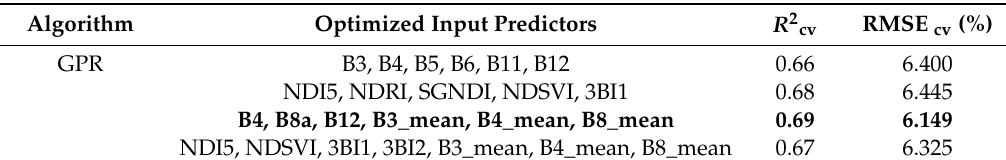
Table 6. Performance of the optimized GPR models. The best-performing input variable combination for GPR is highlighted in boldface.